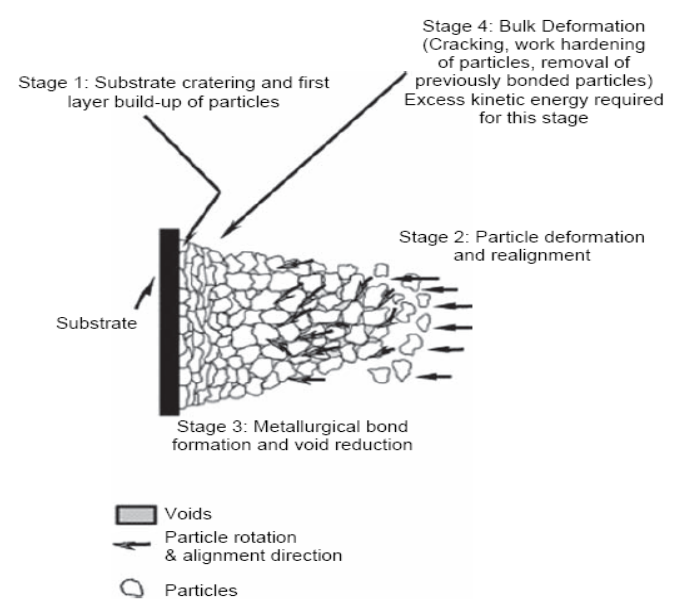
Figure 6: The schematic view of different region of particles on substrate [7].